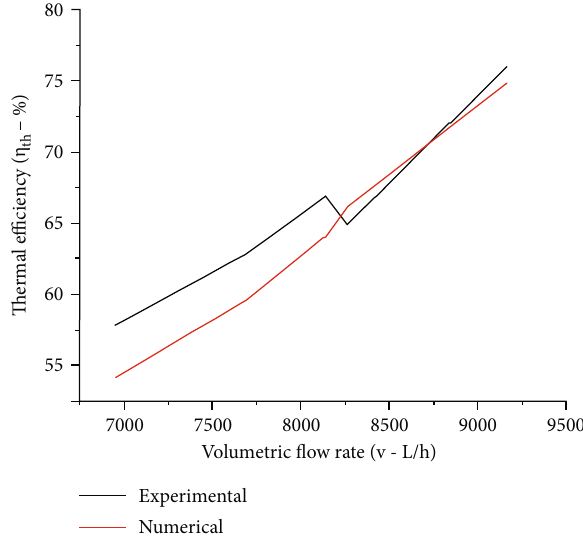
Figure 22: Deviation between experimental and numerical values of thermal e ffi ciency during January to May.